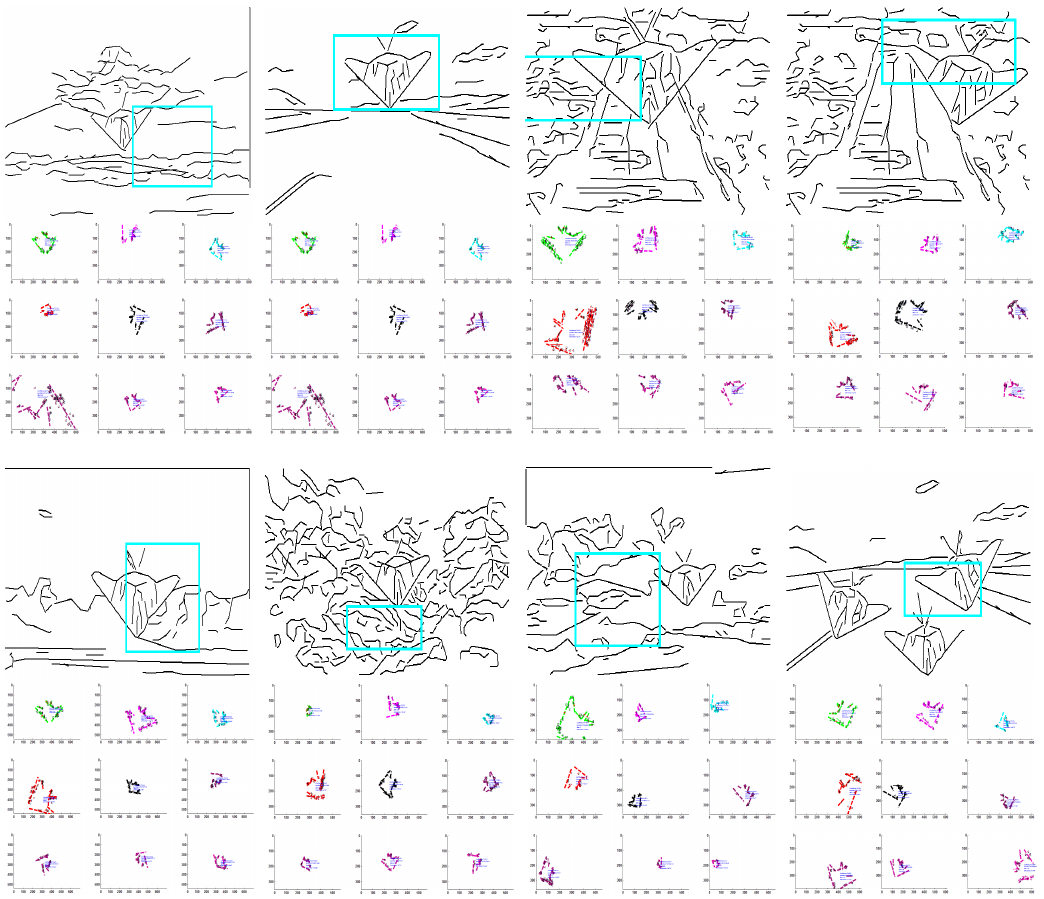
Figure 9. Experimental comparison between our method and DCLE [37,38]. First and third row: detection by DCLE. Second and fourth row: detection by our method. Our method could not only detect the object but could also verify its location, scale, and orientation.